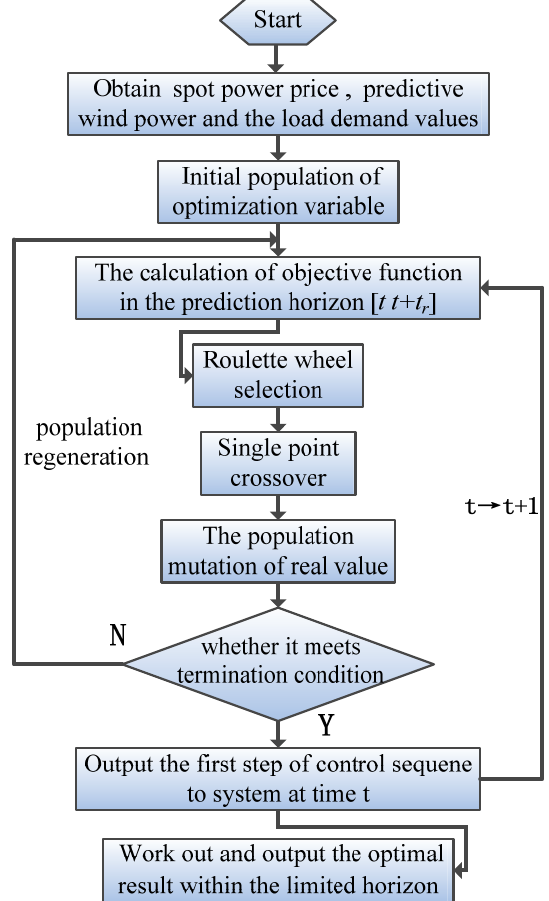
Figure 7. The flowchart of RHC optimization strategy based on